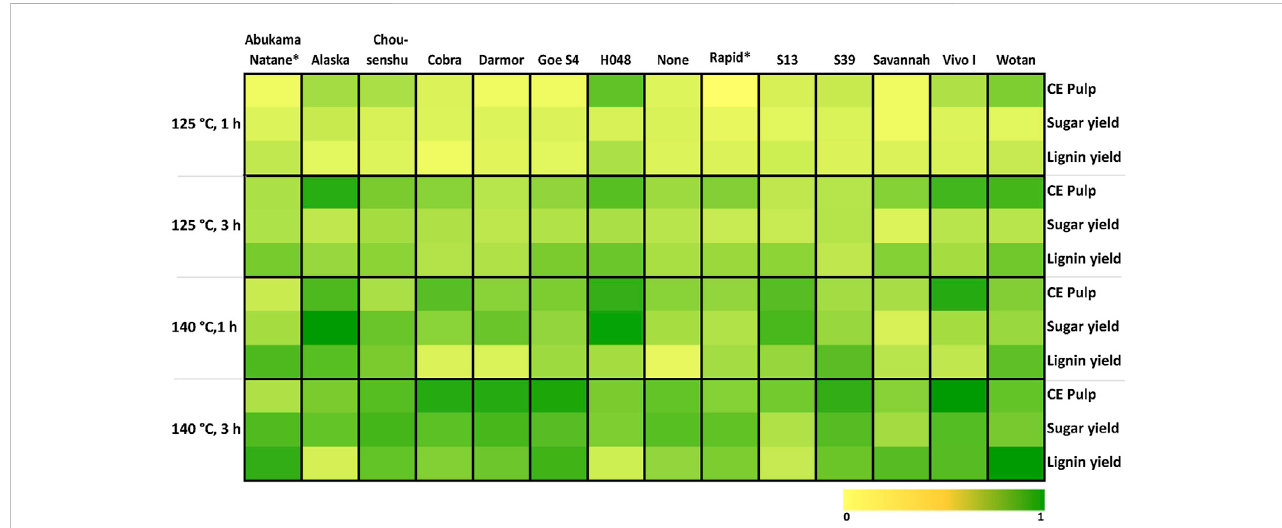
FIGURE 4 Heatmap of OrganoCat processability for 14 rapeseed lines under different conditions. Screening was conducted with the small-scale system design (M-L). Normalizeddataof celluloseenrichment inpulp,and sugar and ligninyield for color gradient.CE Pulp istheincrease inthe relativeamount ofcellulose inthepulpcomparedtotheraw material. Sugaryieldis de fi ned as theamount ofreducingsugars determined intheaqueousphase after pretreatment. Lignin yield is de fi ned as the amount of lignin isolated from the organic phase after pretreatment. *The calculation of the values for CE Pulp at 125 ° C 1 h for Abukama Natane and Rapid resulted in negative numbers, thus these values were set to 0 for simpli fi